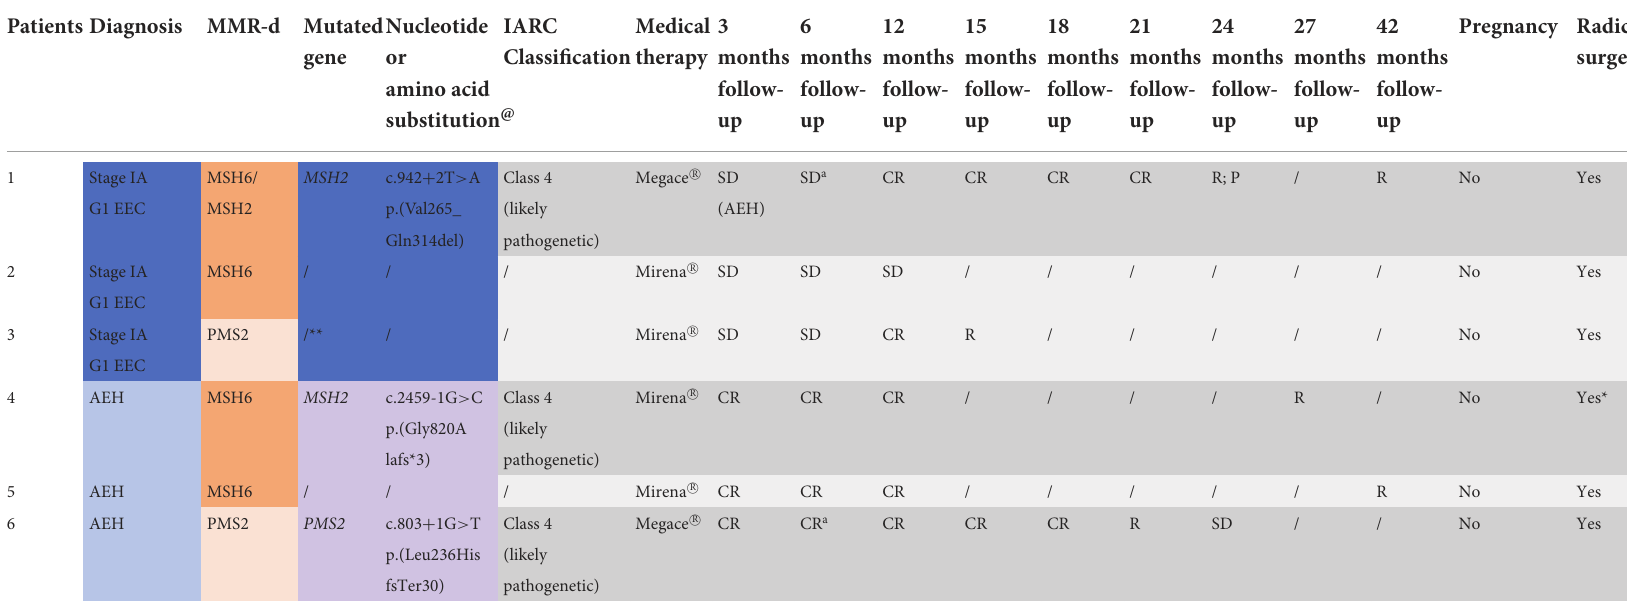
TABLE 2 Diagnosis, MMR-deficiency at immunochemistry, genetic test result with variant identified in patients 1, 4, and 6 and located in a recognized site of splicing ( ± 1 o ± 2), and outcomes of the 6 patients (EEC, Stage IA G1 endometrioid endometrial cancer; AEH, atypical endometrial cancer; PR, partial response; CR, complete response; SD, stable disease; R, relapse; P, progression; § THL + SOB; *for patient’s choice; **drop-out; a LNG-IUD from the 6th month). Patients Diagnosis MMR-d